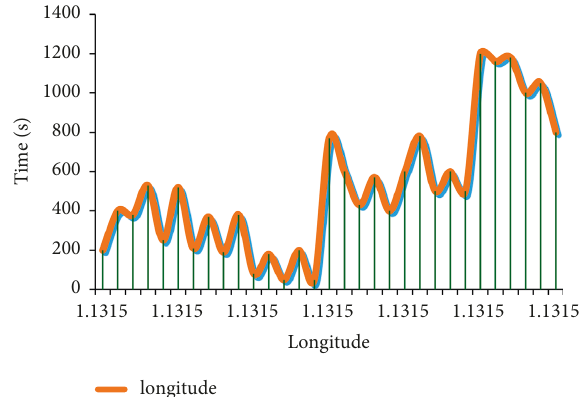
Figure 13: The relationship between longitude and time.